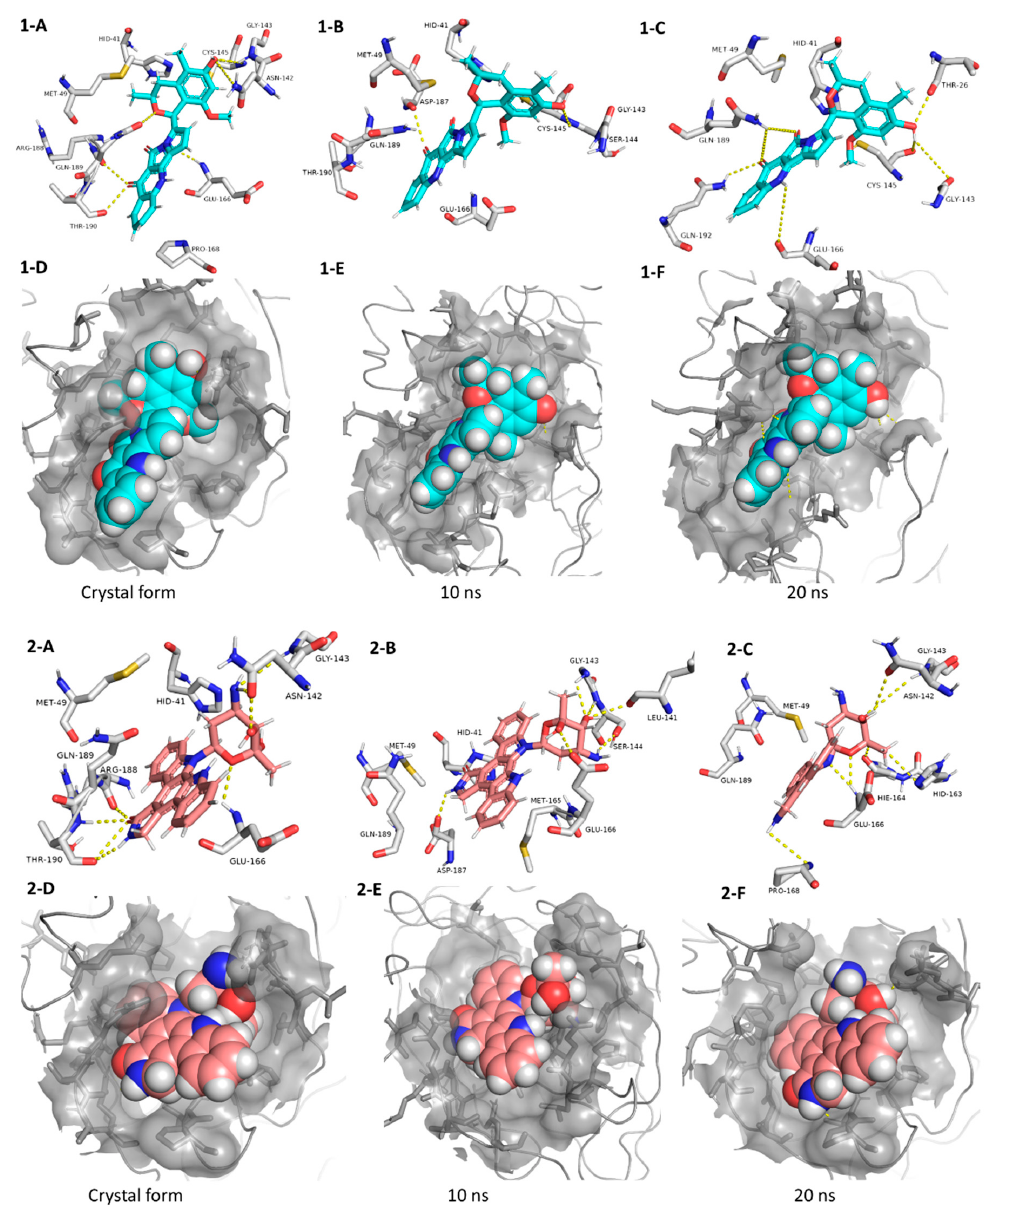
Figure 5. Interactions and binding modes of compounds 1 and 2 (Blue and red molecules, respectively) inside the M pro active site in the crystal form and during MDS ( 1-A – 2-F ).